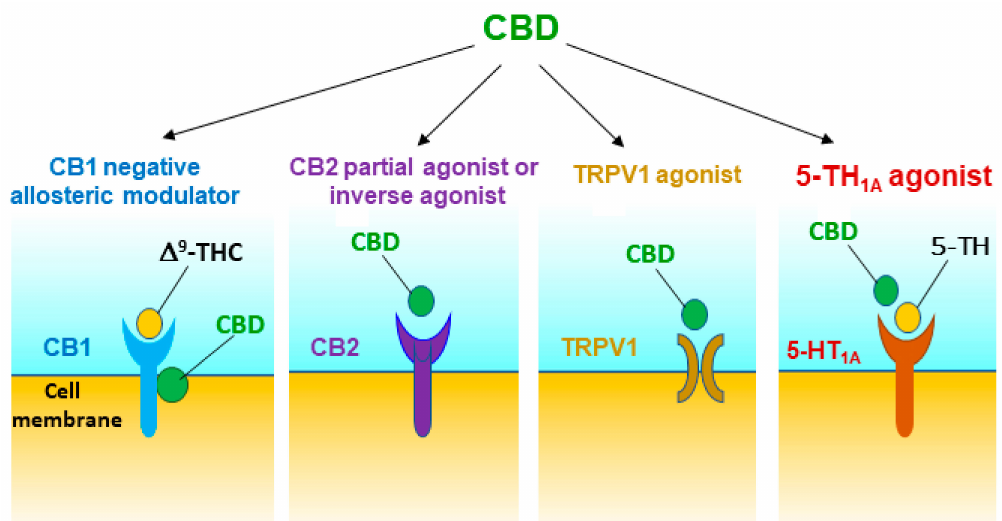
Figure 1. Potential receptor mechanisms underlying CBD’s action against drug reward and addiction. The results from in vitro receptor binding and functional intracellular signalling assays and in vivo behavioral studies with pharmacological and transgenic approaches suggest that CBD may act as a CB1R negative allosteric modulator, a CB2R partial agonist or antagonist/inverse agonist, and a TRPV1 and 5-HT 1A receptor agonist. Multiple receptor mechanisms together produce protective and therapeutic effects against drug abuse and